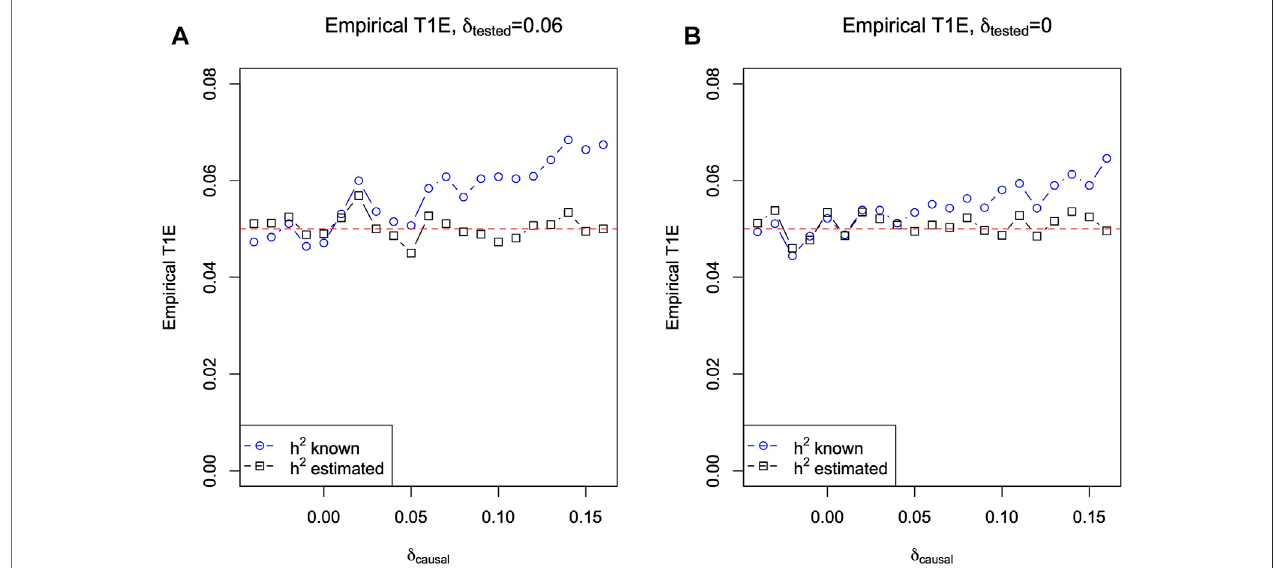
FIGURE3| Empirical typeIerrorrateof T LMM basedonthelinearmixed-effect model( Eq.4 )against δ causal . (A) When G tested oftested SNPsisinHWDwith δ tested =0.06. (B) When G tested oftested SNPs isinHWEwith δ tested =0.The trueheritabilityofthephenotype is h 2 =0.5, theminor allele frequencies p causal = p tested =0.2,and 10,000 independent replicates of phenotypes and genotypes for 65 sibling pairs were simulated for each δ causal value. The blue circles are for T LMM using the true heritability h 2 = 0.5, and the black squares are for T LMM while estimating h 2 (results of ^ h 2 are shown in Figure 1 ).